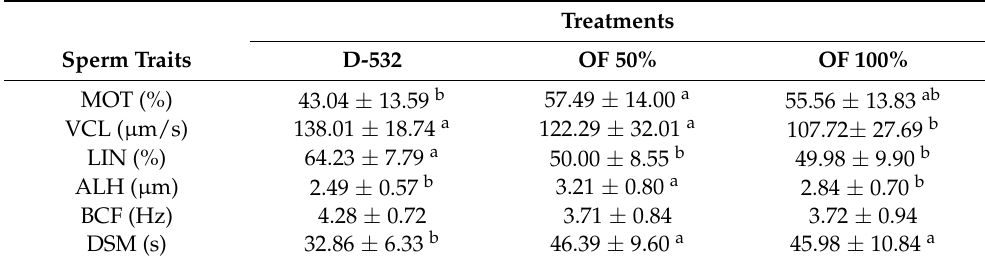
Table 1. Main sperm motility parameters (means ± SD) in D-532, OF 50% and OF 100% and pairwise comparison among treatments.